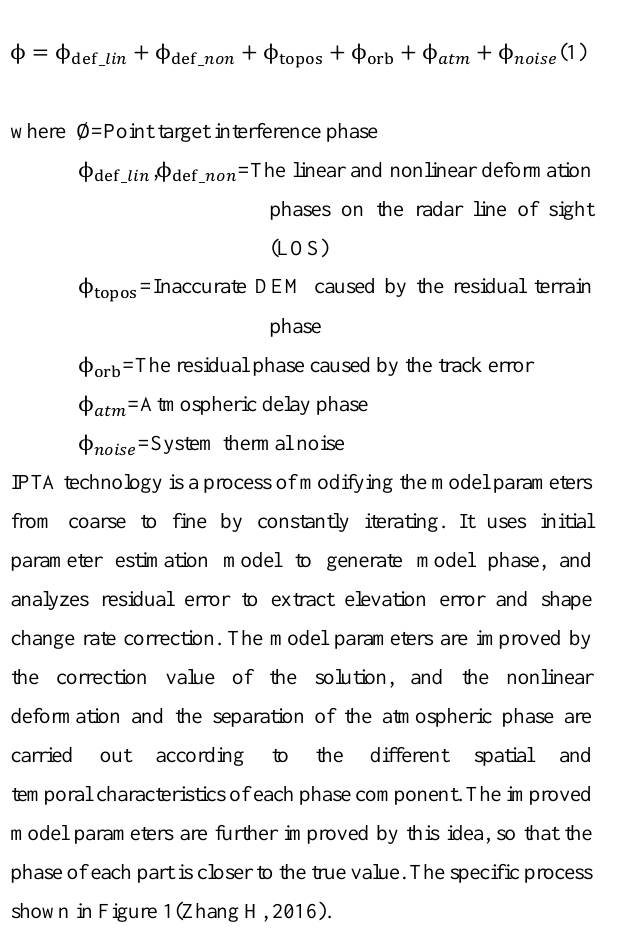
Figure 1 IPTA flow